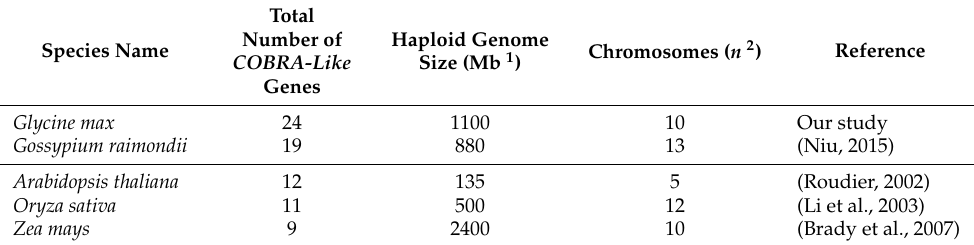
Table 2. COBRA-like gene distribution among species.